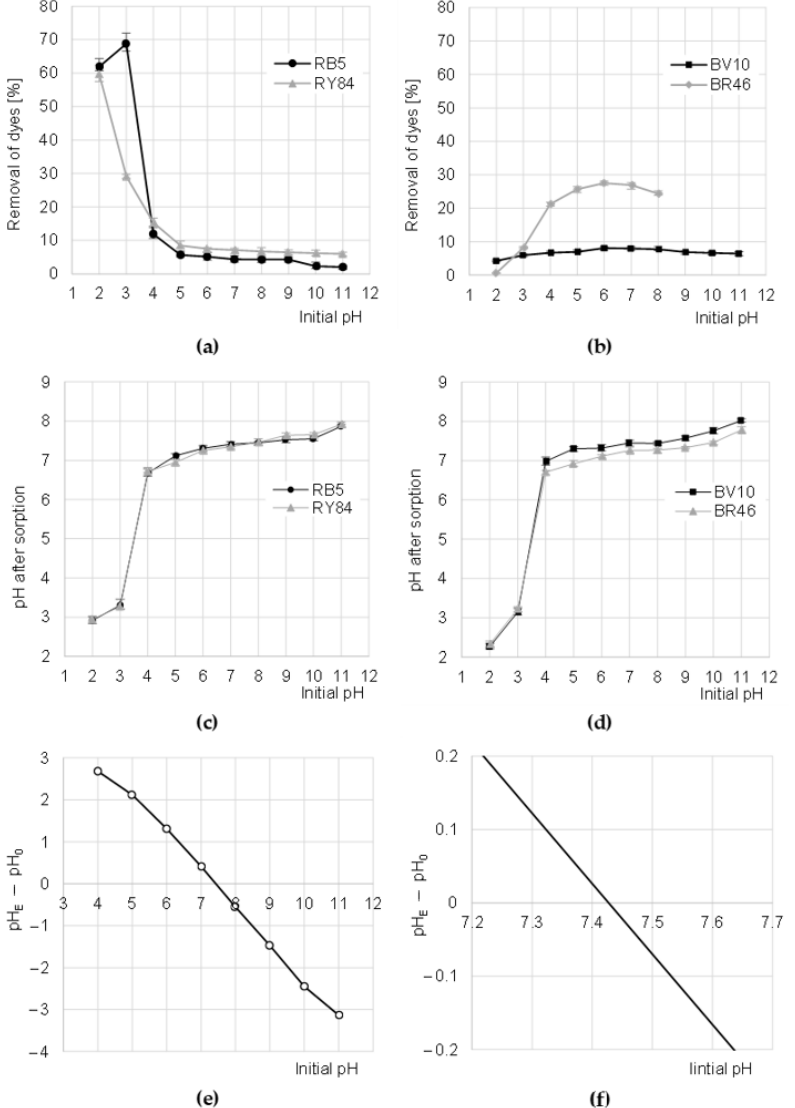
Figure 3. Effect of pH on the efficiency of sorption of: ( a ) anionic, and ( b ) cationic dyes onto CHM (average + range). Effect of CHM on changes in solution pH after sorption of: ( c ) Anionic and ( d ) cationic dyes. ( e , f ) Determination of pH PZC of the CHM with the Boehm’s titration method. Temp. 22 °C.